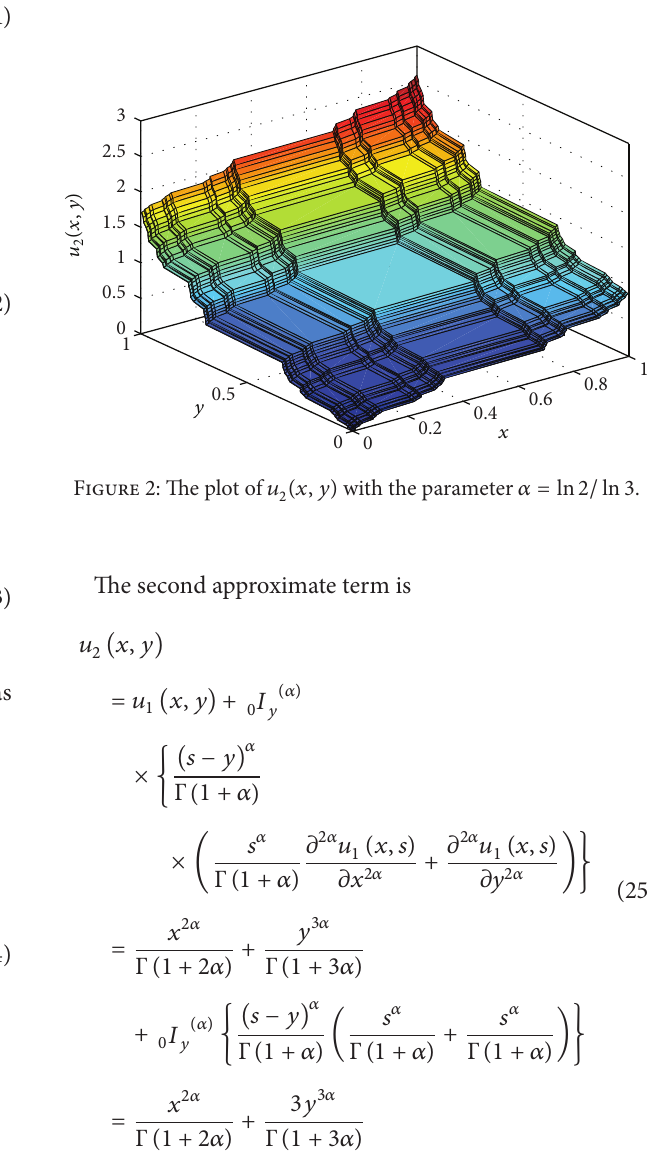
and its graph is given in Figure